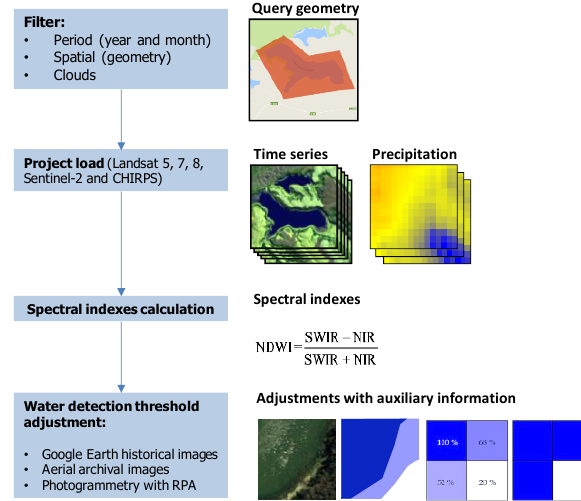
Figure 1. Methodological scheme of surface water detection using spectral